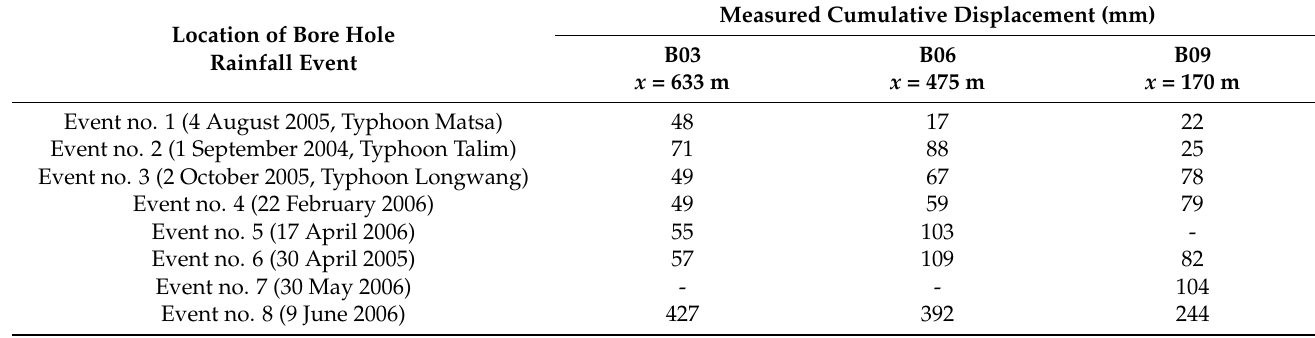
Figure 14. Records of daily rainfall, groundwater levels, and cumulative slope displacements.